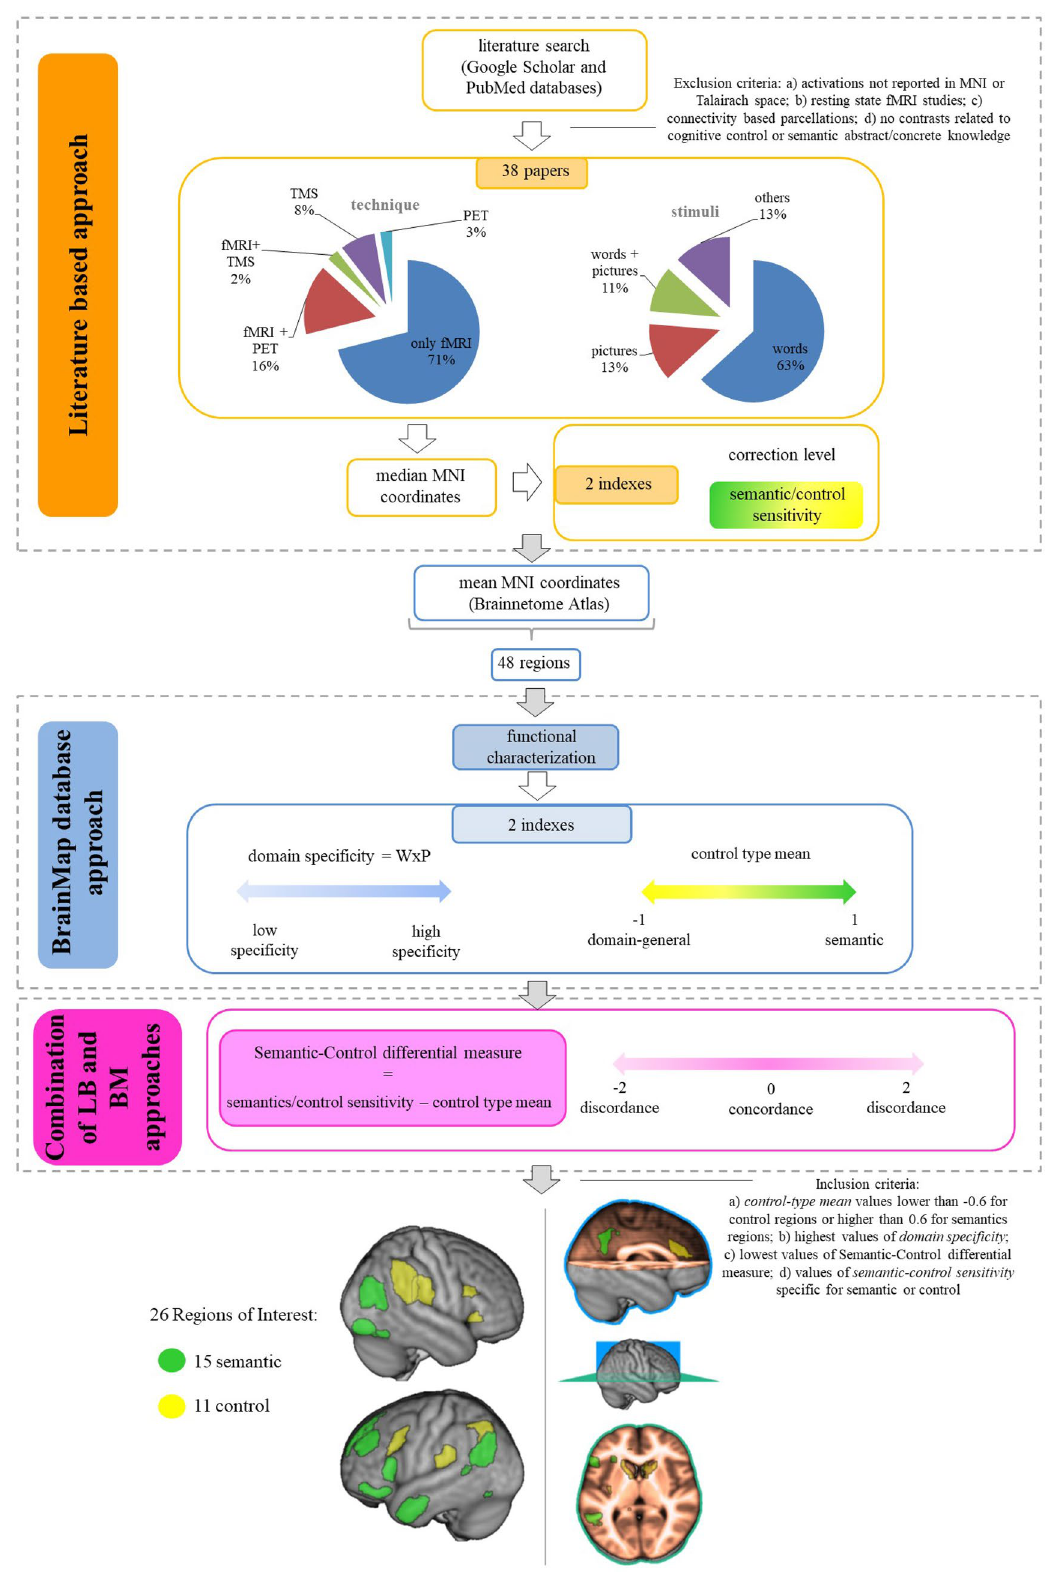
Figure 3. Schematic illustration of ROIs’ selection